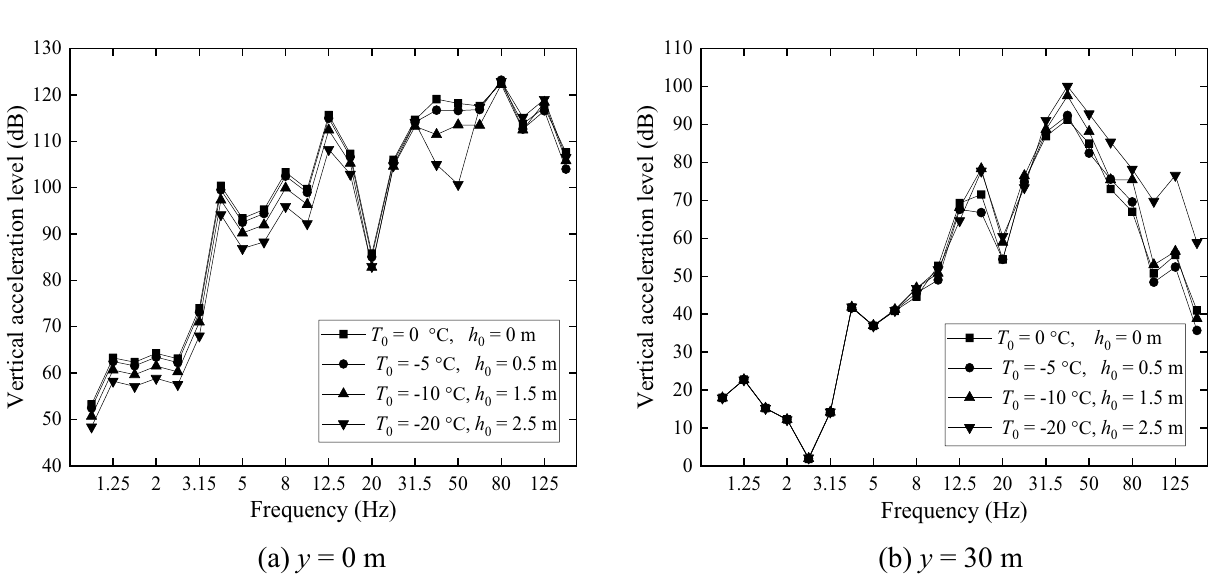
Figure 18. Ground vibration acceleration level in one-third octave bands at x = 0, ( a ) y = 0 m and ( b ) y = 30